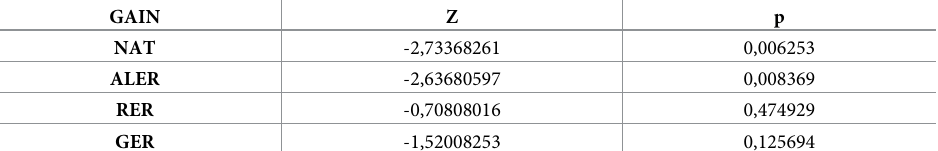
Table 8. Comparison of multisensory gains between the two cohorts (below and above 12 years of age). Results of the hypothesis tests (Mann-Whitney U). The conventions are the same as in Figs 3 and 4. GAIN